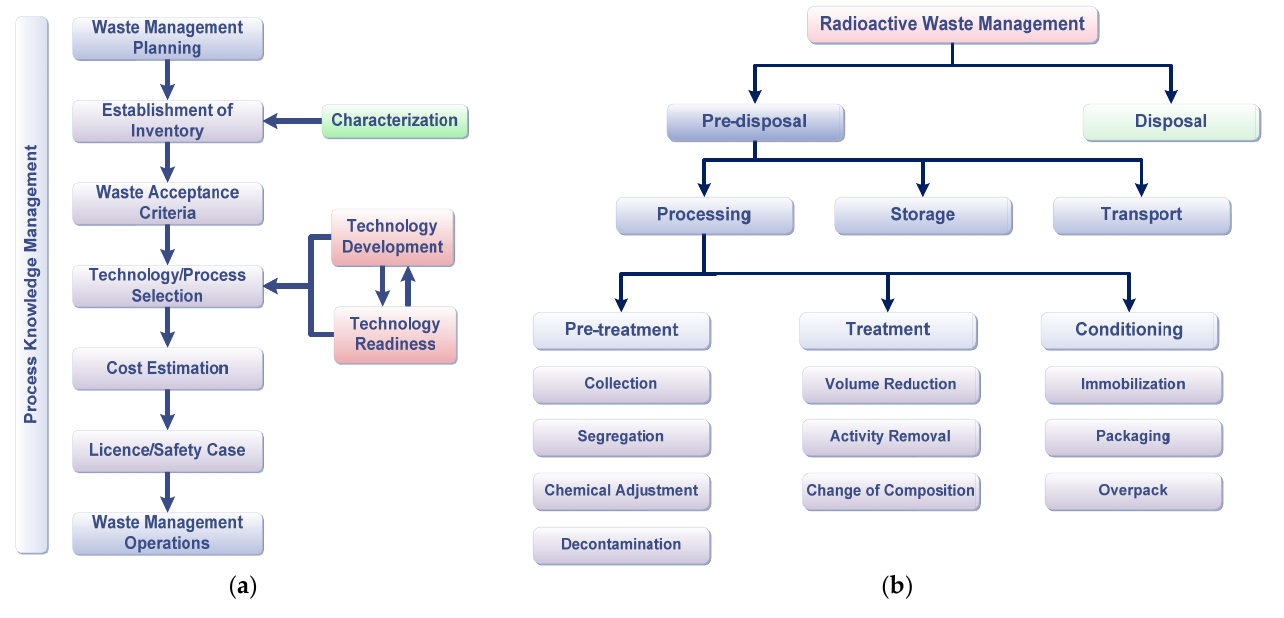
Figure 1. Schematic of nuclear waste management (NWM) administrative ( a ) and operational ( b ) activities. The operational activities are sub-divided into pre-disposal and disposal activities.